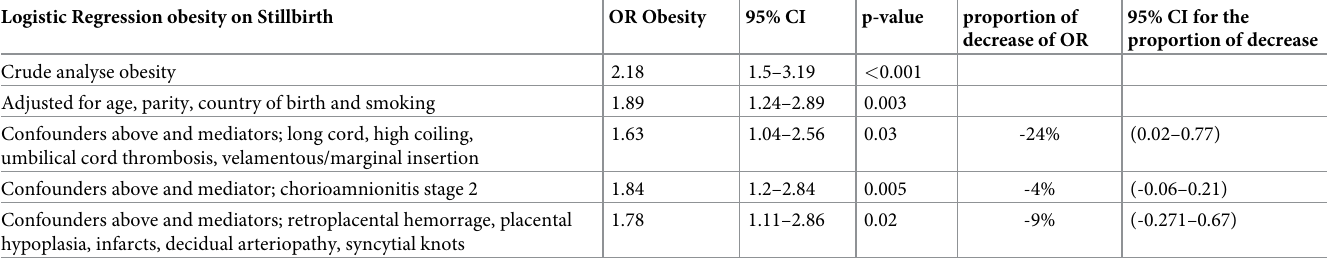
groups of potential mediators, placental or umbilical cord